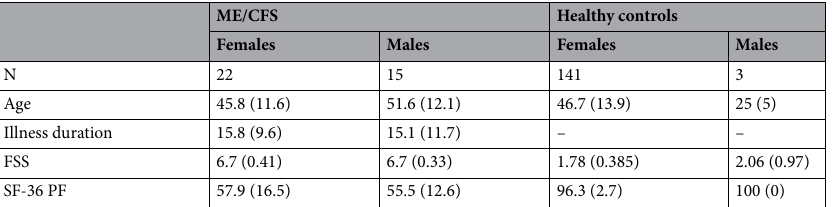
Table 1. Demographic information of study participants. Illness duration is in years. FSS fatigue severity scale, SF‑36 PF short form 36, physical functioning subscale. Numbers in parentheses are standard deviations.